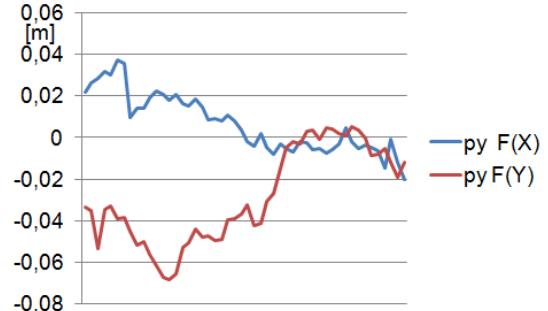
Figure 6. Systematic y-parallaxes of Pleiades-1A, Zonguldak